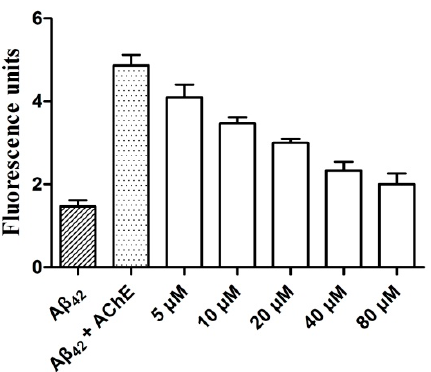
Figure 4. Determination of 5c inhibition potency on AChE-induced amyloid- β (A β ) 42 aggregation.